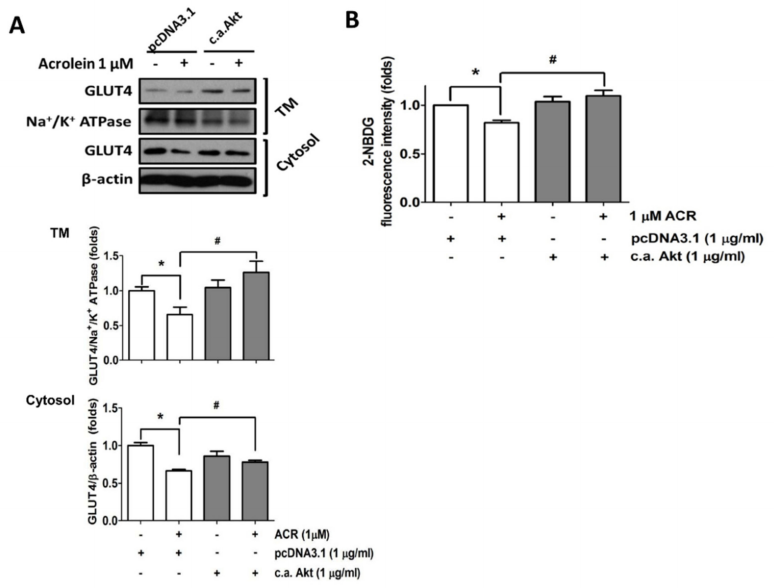
Figure 6. Over-expression of the constitutively active form of Akt ameliorates the inhibitory effects of acrolein on GLUT4 and glucose uptake in myotubes. Myotubes were transiently transfected with control pcDNA3.1 or c.a. Akt for 24 h, and then exposed to 1 µ M acrolein for 24 h. ( A ) The protein expressions of GLUT4 from total membrane (TM) fraction and cytosol fraction were determined by Western blotting and quantified using densitometric analysis. ( B ) The uptake of 2-NBDG into the myotubes was evaluated by a microplate fluorometer. Results are represented as means ± SEM for at least four independent experiments. * p < 0.05 versus vehicle control; # p < 0.05 versus acrolein +